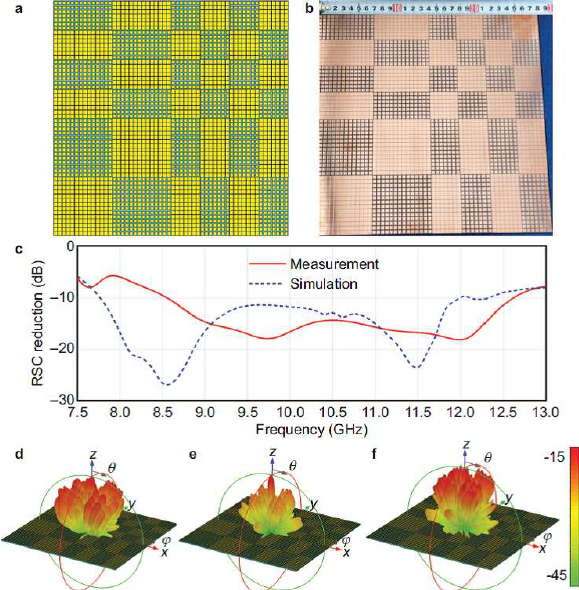
Figure 11: From [199]: (a) Simulated and (b) experimental metasur- face with optimized 1 bit encoding for manipulating directivity of reflection under normal incidence and lowering the electromagnetic radar cross section (RCS). (c) Simulated and measured values of RCS reduction over a wide frequency range of 7.5 to 13 GHZ. (d-f) Simulated scattering patterns at 8, 10 and 11.5 GHz respectively. The metasurface redirects incident light to a much broader range of angles, resulting in significant reductions (more than 10 dB differ- ence on average) to RCS. Reprinted with permission from Ref.